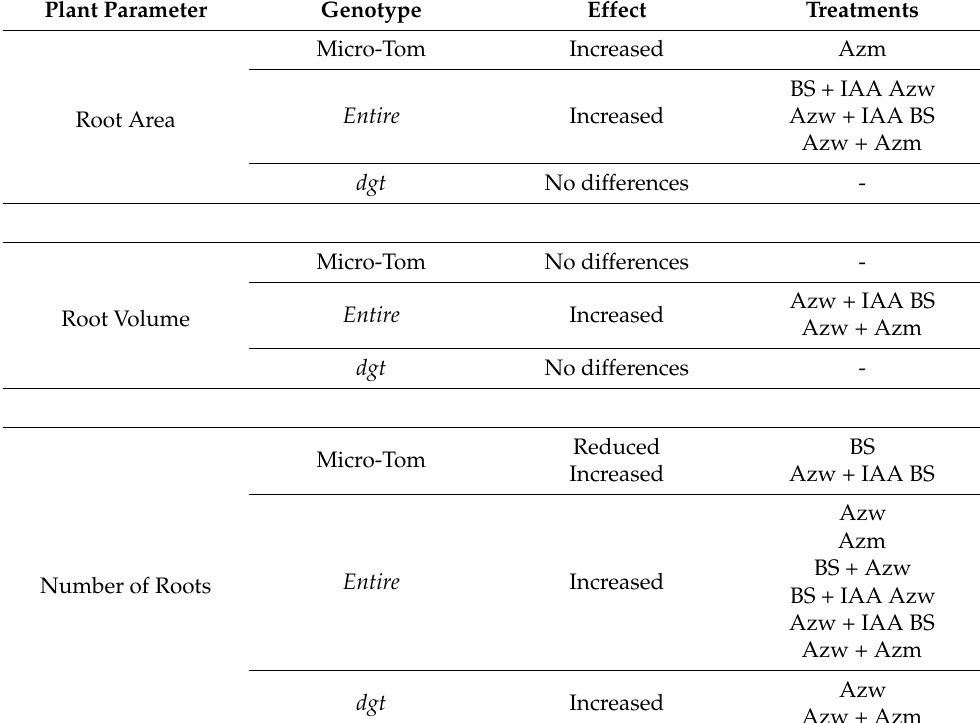
Table 2. Cont. Plant Parameter Genotype Effect Treatments